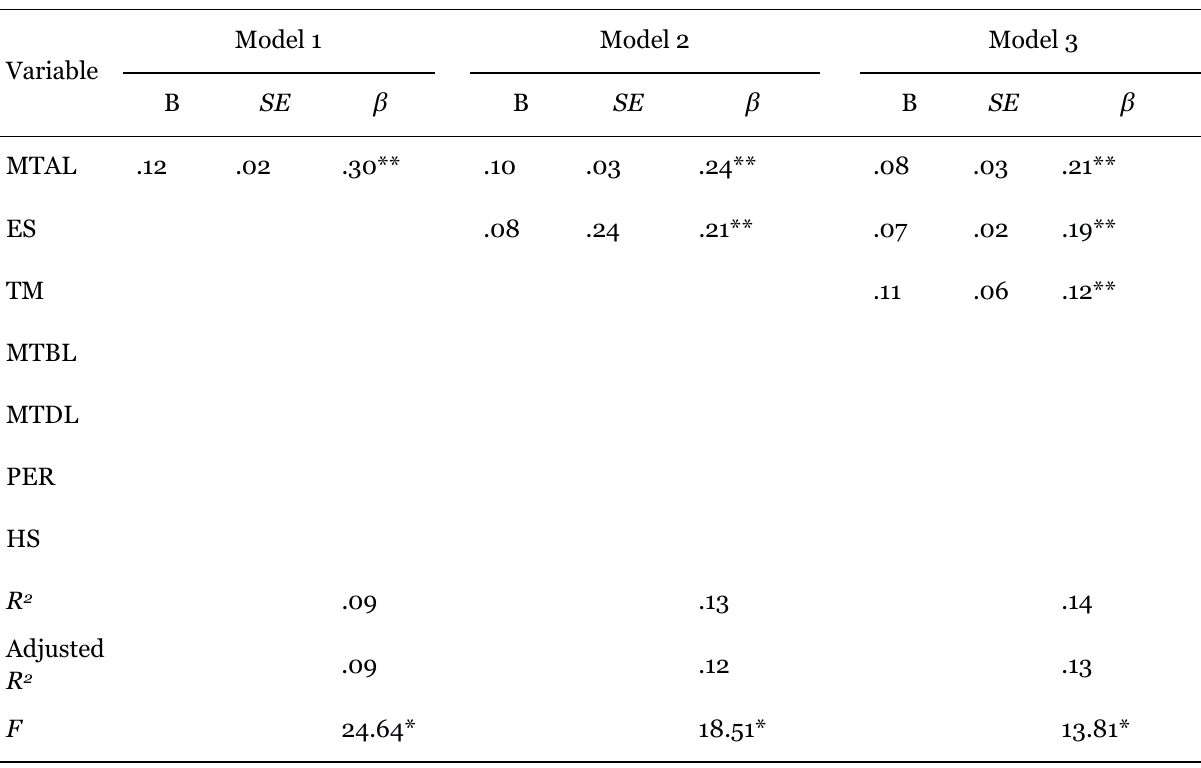
Results of Stepwise Multiple Regression